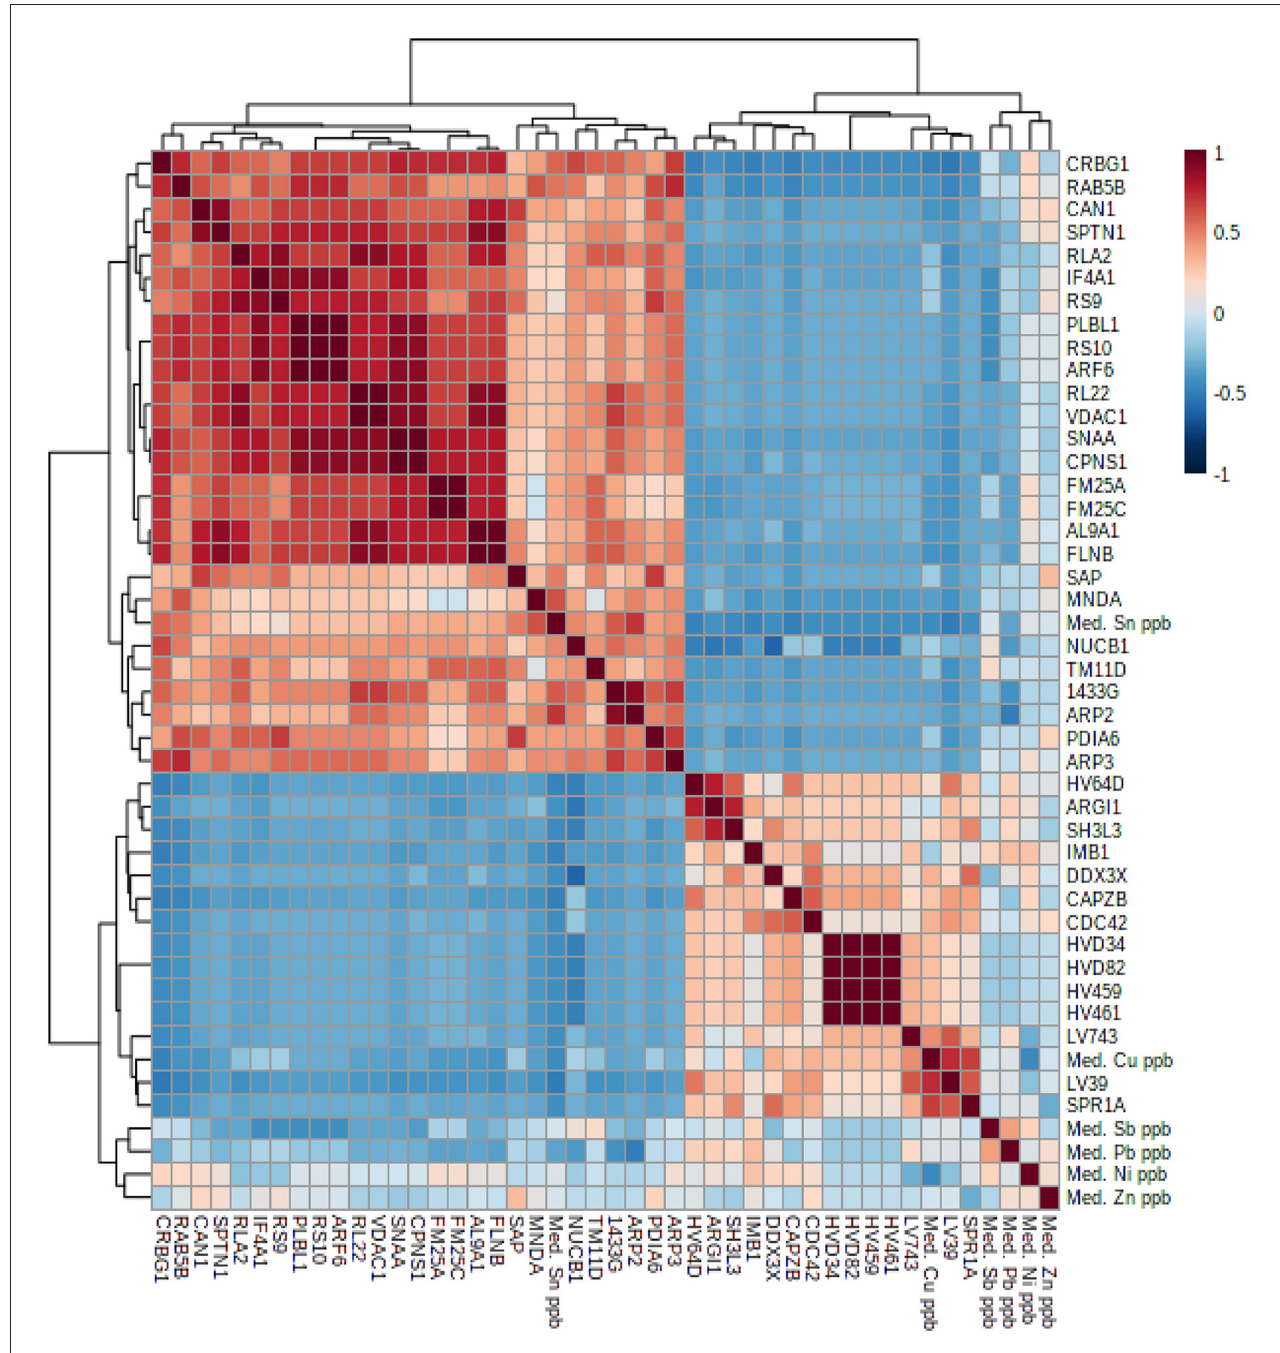
FIGURE1 Correlation heatmap with hierarchical cluster analysis based on Pearson correlation coefficient. Distance is scaled and values range from 1 (red color) to − 1 (dark blue color). Correlation of gene saliva expression associated with blood Ni, Cu, Zn, Sn, Sb, and Pb metal concentrations.